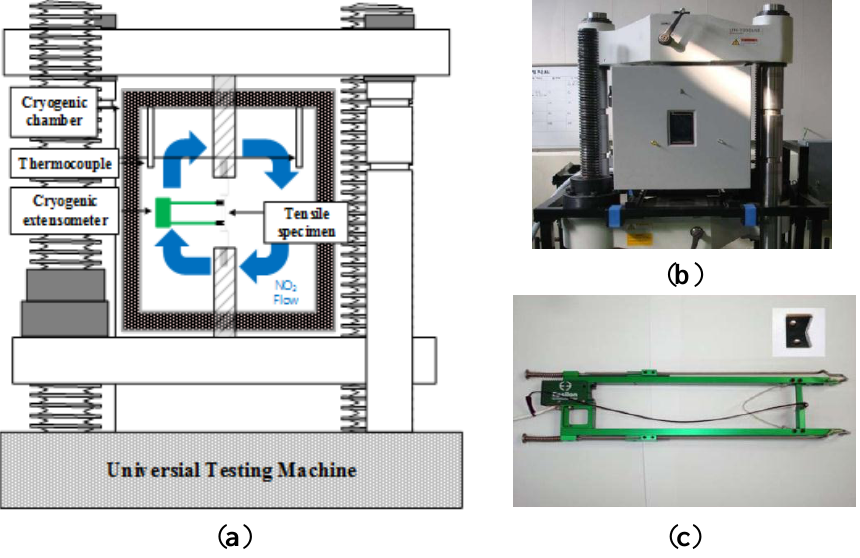
Figure 3. ( a ) Schematic of custom low temperature test machine; ( b ) photography of universal testing machine; SHIMADZU, UH-1000KNI with cryogenic chamber and ( c ) cryogenic extensometer and knife edge